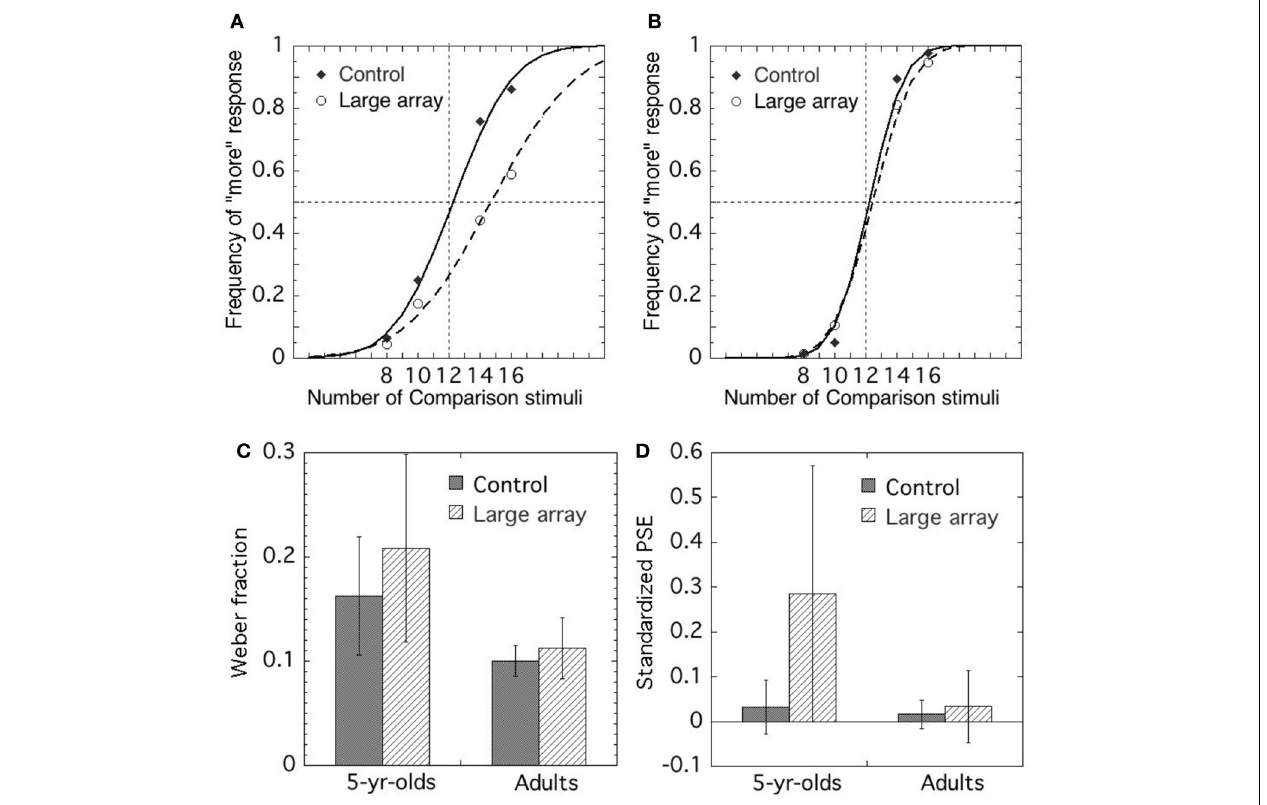
FIGURE 6 | Choice frequency of more elements as a function of the number of comparison stimuli in (A) 5-year-olds and (B) adults. Mean Weber fraction (C) and standardized PSE (D) of each condition in 5-year-olds and in adults. Error bars represent standard deviations.